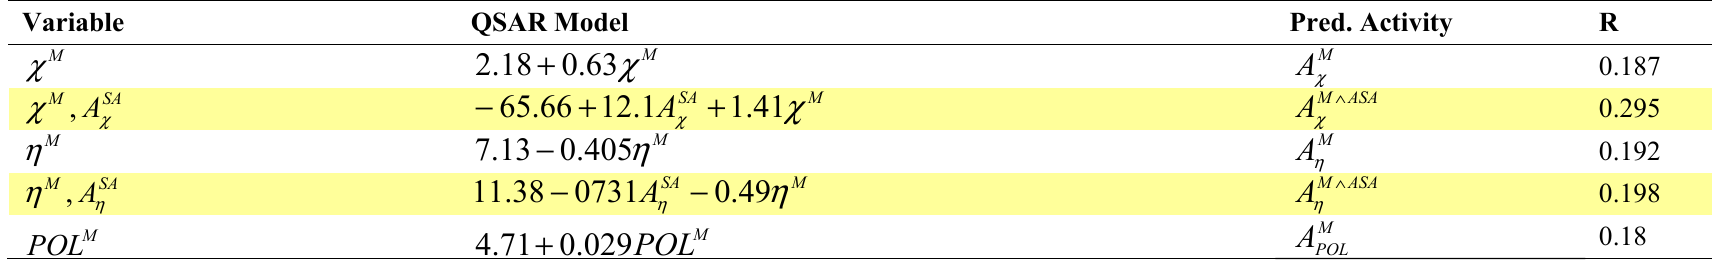
Table 4. Multi-linear QSAR models for the trial molecular activities with the full molecular (M) physicochemical parameters of Table 1 and the corresponding activities of the structural alerts (A SA or ASA) from Table